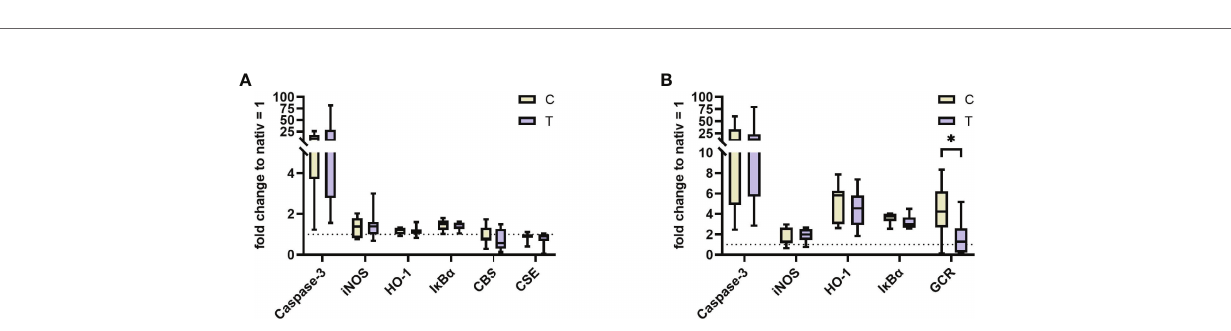
FIGURE 5 | Western Blot analysis of kidney (A) and lung (B) at the end of the trial for n = 7/8 animals per group for vehicle control (yellow, C) and thiosulfate (purple, T), respectively. Results are normalized to protein levels from two untreated animals. iNOS, inducible nitric oxide synthase; HO-1, heme oxygenase 1; I k B a , nuclear factor of kappa light polypeptide gene enhancer in B-cells inhibitor, alpha; CBS, cystathionine- b -synthase; CSE, Cystathionine- g -lyase; GCR, glucocorticoid receptor. * = p < 0.05, Mann-Whitney U test. Box plots report median, interquartile range, minimum, and